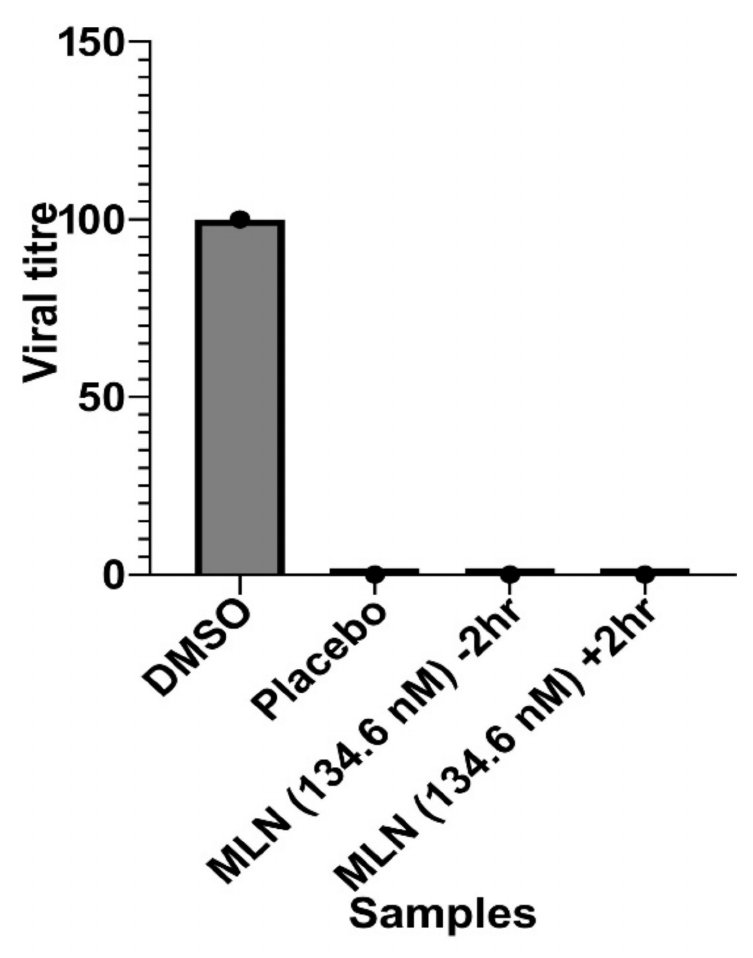
Figure 6. Evaluation of antiviral activities of MLN. It shows the results of entry vs. spread assays. Against virus attachment and entry/fusion, the assay was pre-treated with MLN 2 h before adding the virus to the host cell line. The experimental procedure, virus concentration (PFU/well or MOI), and the time of addition and treatment with the test compounds are presented in the method sections. Against virus replication, the same assay was conducted with a 2 h delayed drug treatment, i.e., post-introduction of viruses giving plenty of time for the viral entry. MLN has consistent activity in both assay modes. There could be multiple mechanisms complementing as this compound completely blocks the SARS-CoV-2 cycle in both assay